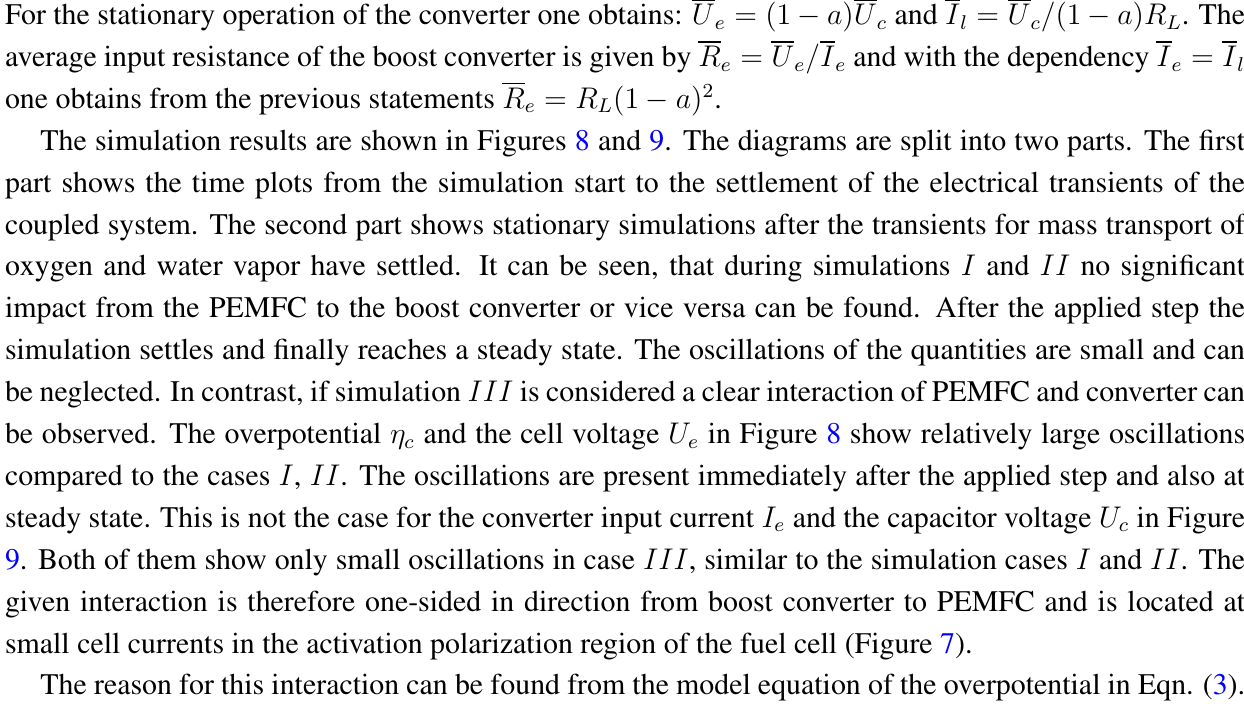
and stationary voltage-current profile of the PEM L